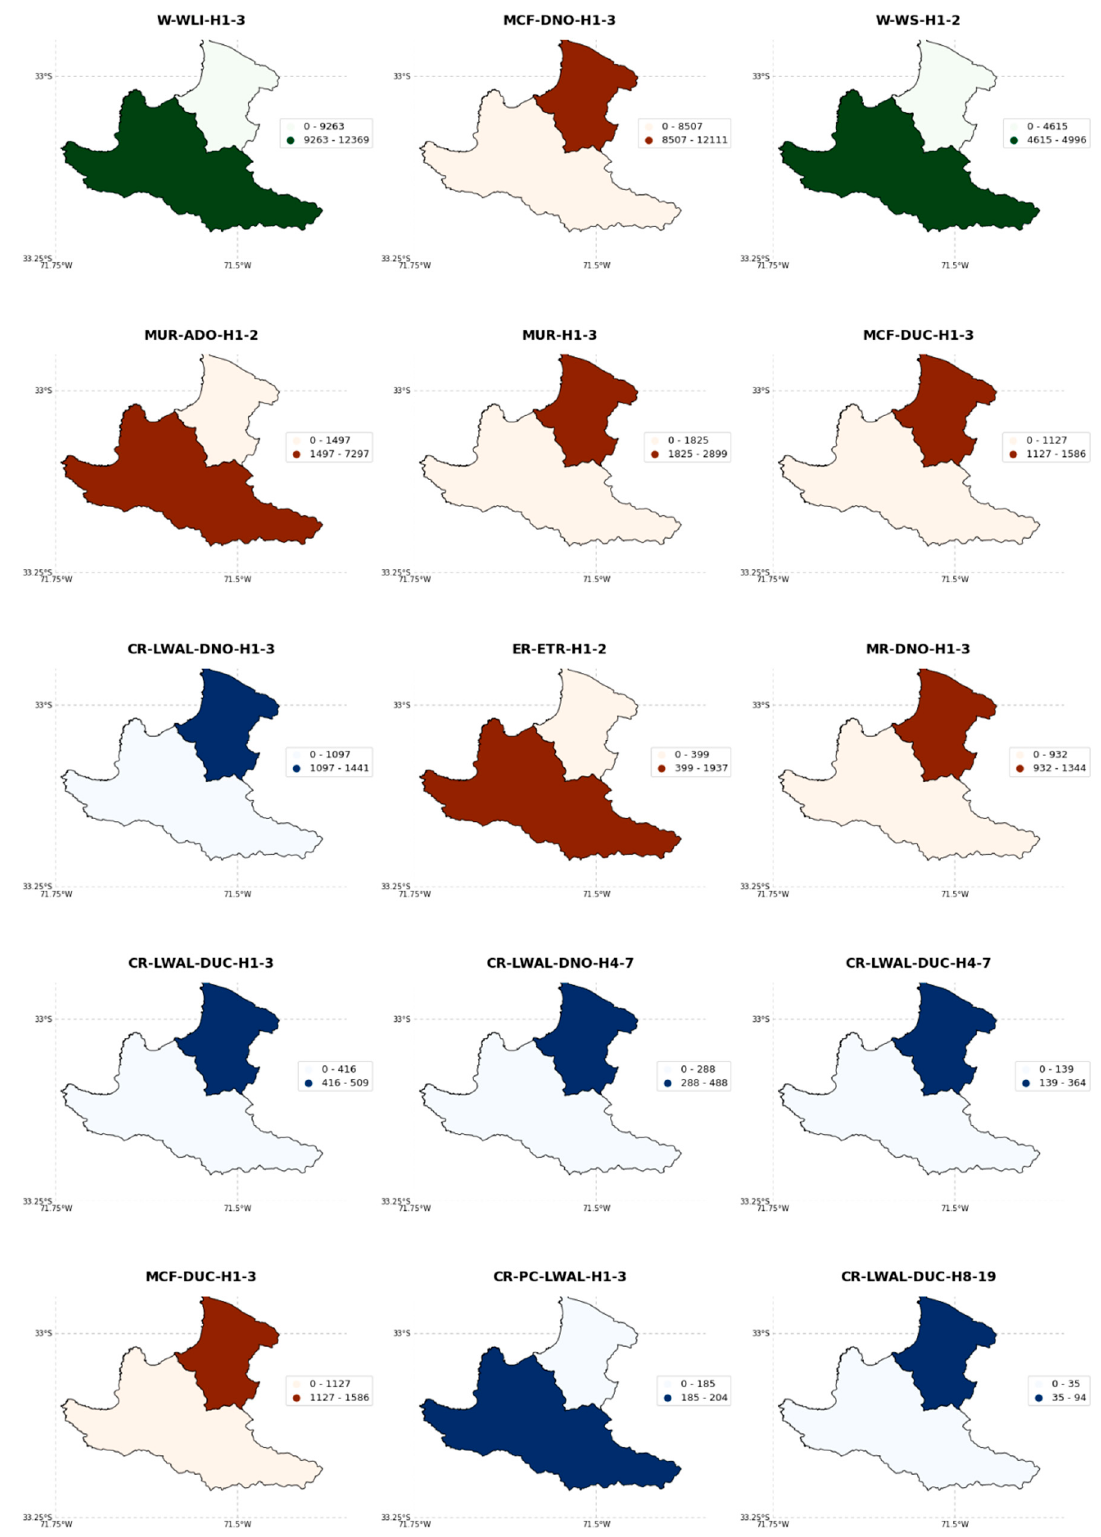
Figure 3. Building counts at the commune level for 15 SARA building classes (after having combined similar typologies (Section 3.2.1)). The colour scale represents the material type (green = wooden; orange = masonry; blue = reinforced concrete).